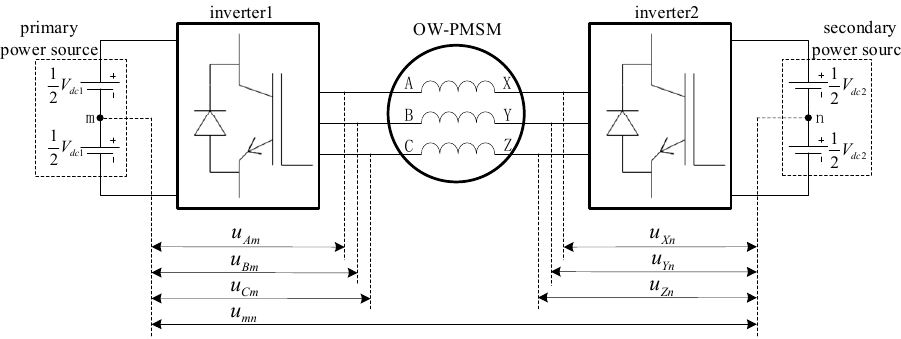
Figure 2. Schematic diagram of mid-point voltage.